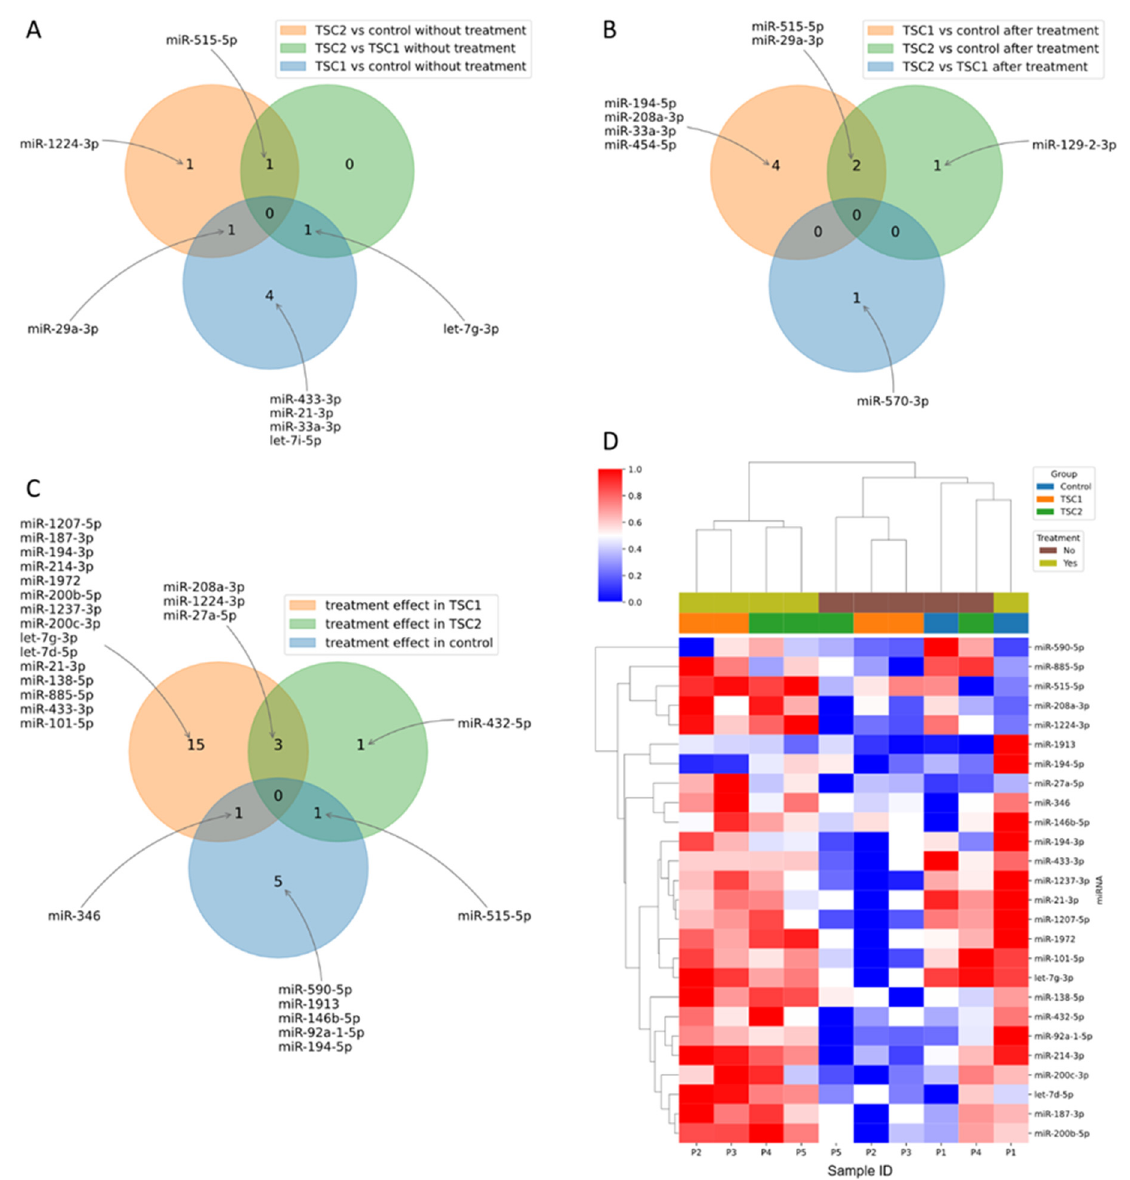
Figure 2. Overlap of differentially expressed miRNAs before ( A ) and after ( B ) rapamycin treatment. Overlap of treatment effects in TSC1 defect, TSC2 defect and control ( C ). Expression of miRNAs changed during rapamycin treatment in any of the groups ( D ).